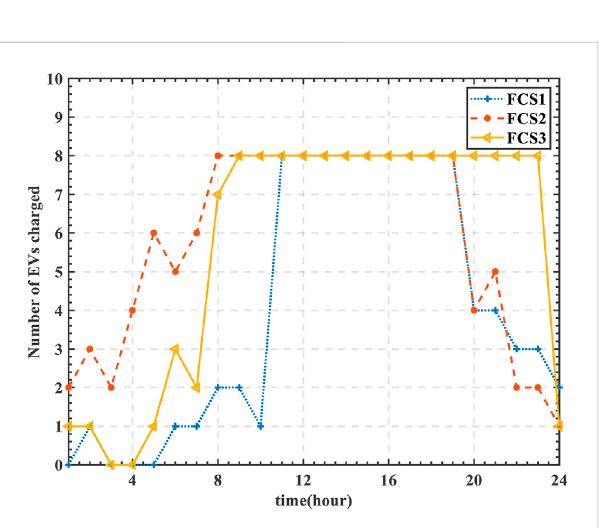
FIGURE 8 Distribution of EVs charged for the FCSs selection of shortest the travel time